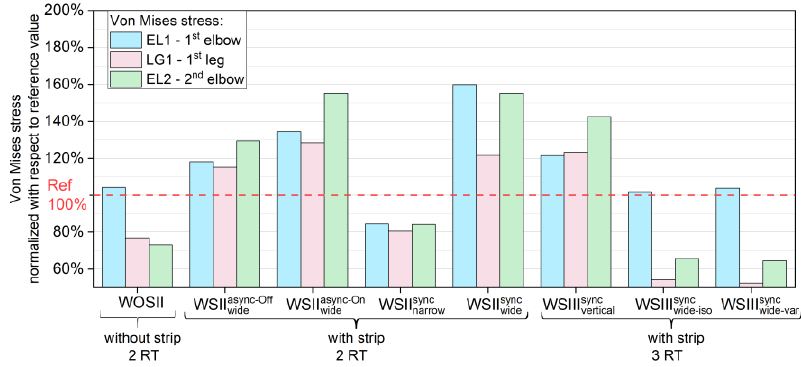
Commented [S14]: Please define if appropriate. Commented [DB15R14]: added